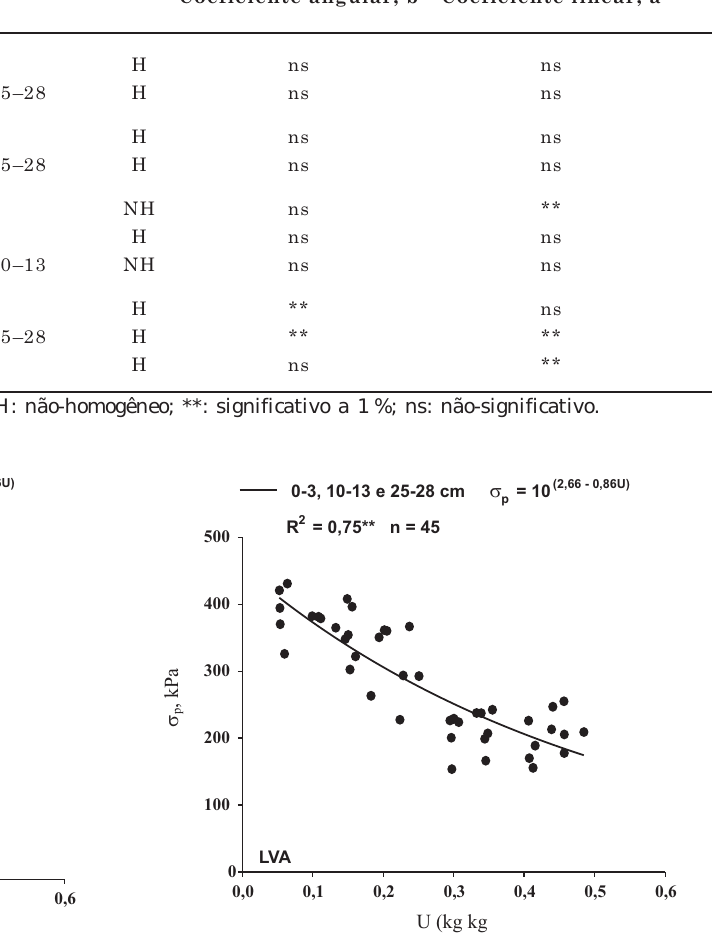
Figura 2. Modelo de capacidade de suporte de carga (CSC) para o sistema de manejo herbicida de pós- emergência (HPÓS) no centro da entrelinha, para : pressão as camadas de 0–3, 10–13 e 25–28 cm. U: umidade, p σσσσσ : pressão de p